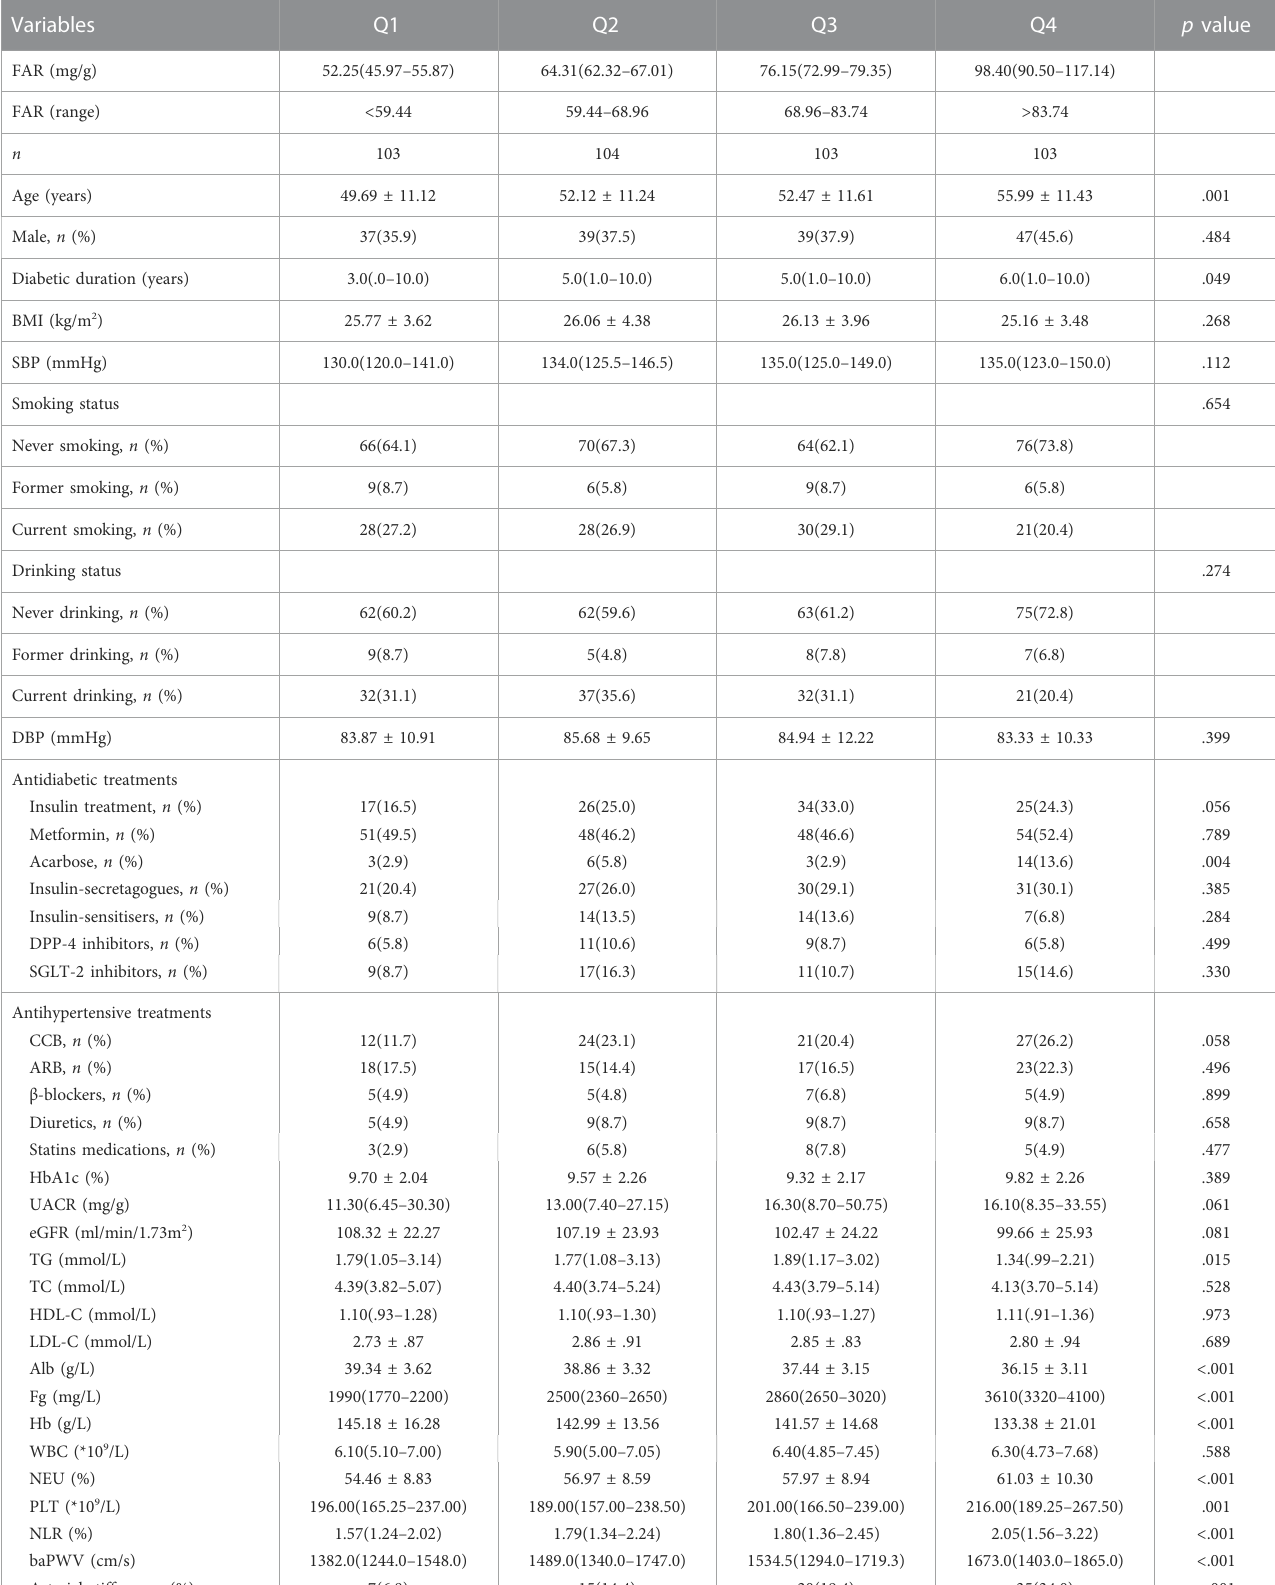
TABLE 1 Clinical characteristics of the study